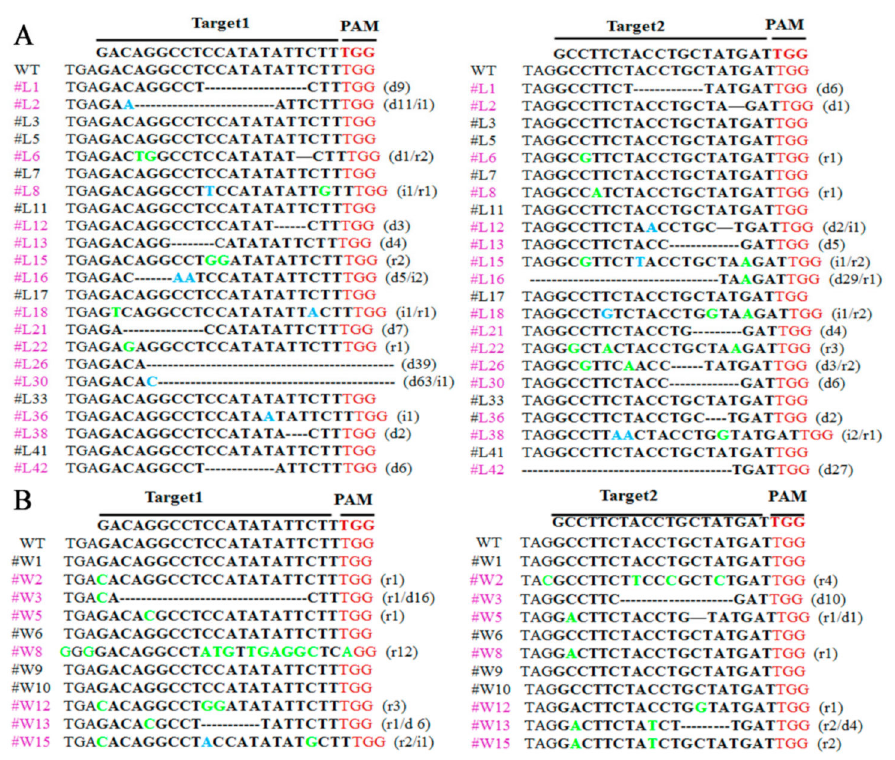
Figure 7. Di ff erent types of mutations detected in transgenic Lilium plants after CRISPR / Cas9-mediated gene editing. PAM, red. Bold, target sequence. r / green, replacements. i / blue, insertions. d / -, deletions. The purple font indicates the presence of mutant lines. Black fonts indicate lines that have not been mutated. #L, PCR-positive lines of Lilium pumilum DC. Fisch. #W, PCR-positive lines of ‘White